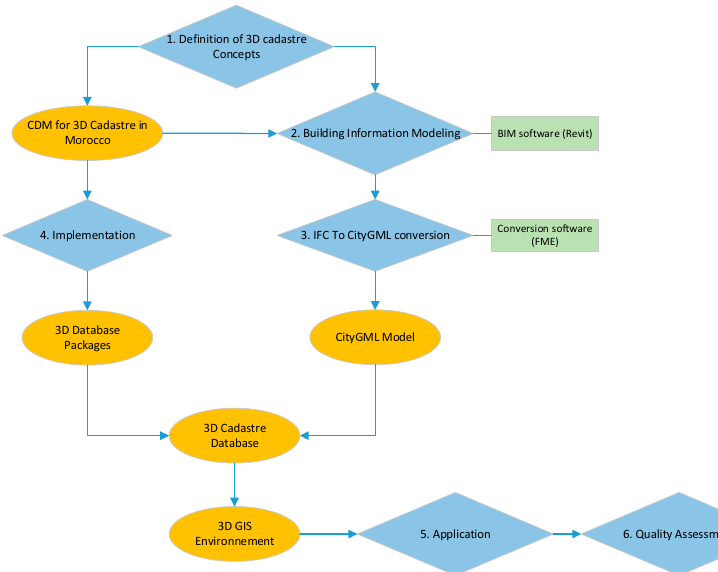
Figure 5. Main stages of the methodology.